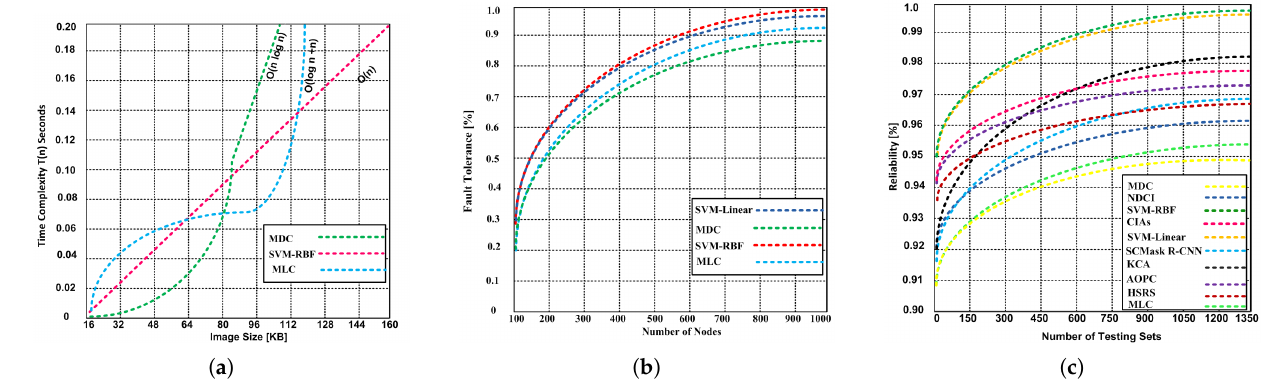
Figure 14. Time complexity, fault tolerance and reliability. ( a ) Time complexity of SVM-RBF, MDC and MLC; ( b ) Fault tolerance of SVM-RBF, MDC and MLC; ( c ) Reliability of SVM-RBF, SVM-Linear, NDCI, SCMask R-CNN, CIAs, KCA, HSRS, and AOPC and MDC and MLC